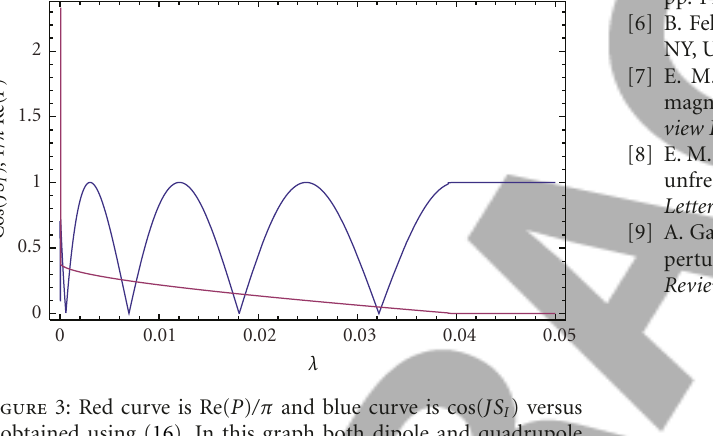
Figure 3: Red curve is Re( P ) /π and blue curve is cos( JS I ) versus λ obtained using (16). In this graph both dipole and quadrupole excitations are